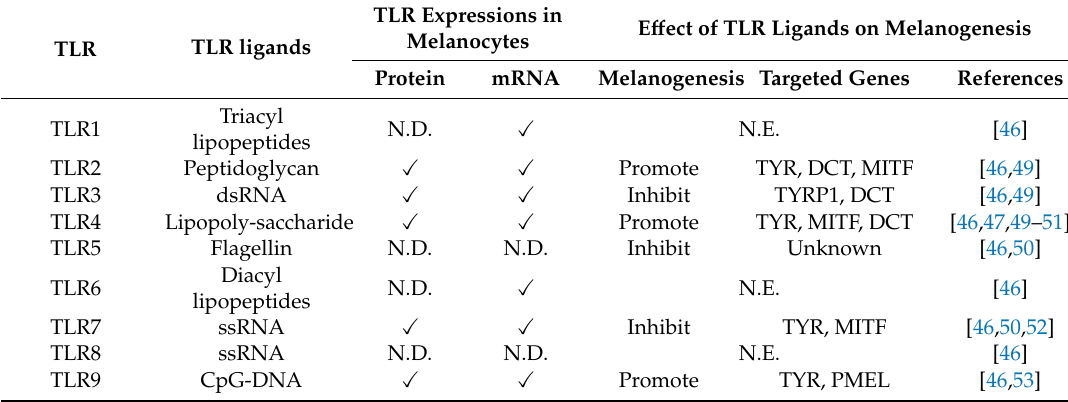
Table 2. E ff ect of innate immune stimulation on melanin transfer from melanocyte to keratinocytes. Action TLR2 TLR3 E ff ect Promote Targeted molecule Rab27A Melanin Transfer in MC N.E. Ref. E ff ect Promote Promote Targeted molecule Rab11A Rab11A Melanin Release from MC Ref. E ff ect Promote Melanin Uptake by KC Targeted genes PAR-2 RHOA CDC42 N.E. Ref. E ff ect Promote Melanin Targeted molecule Autophagy activation in KC N.E. Degradation